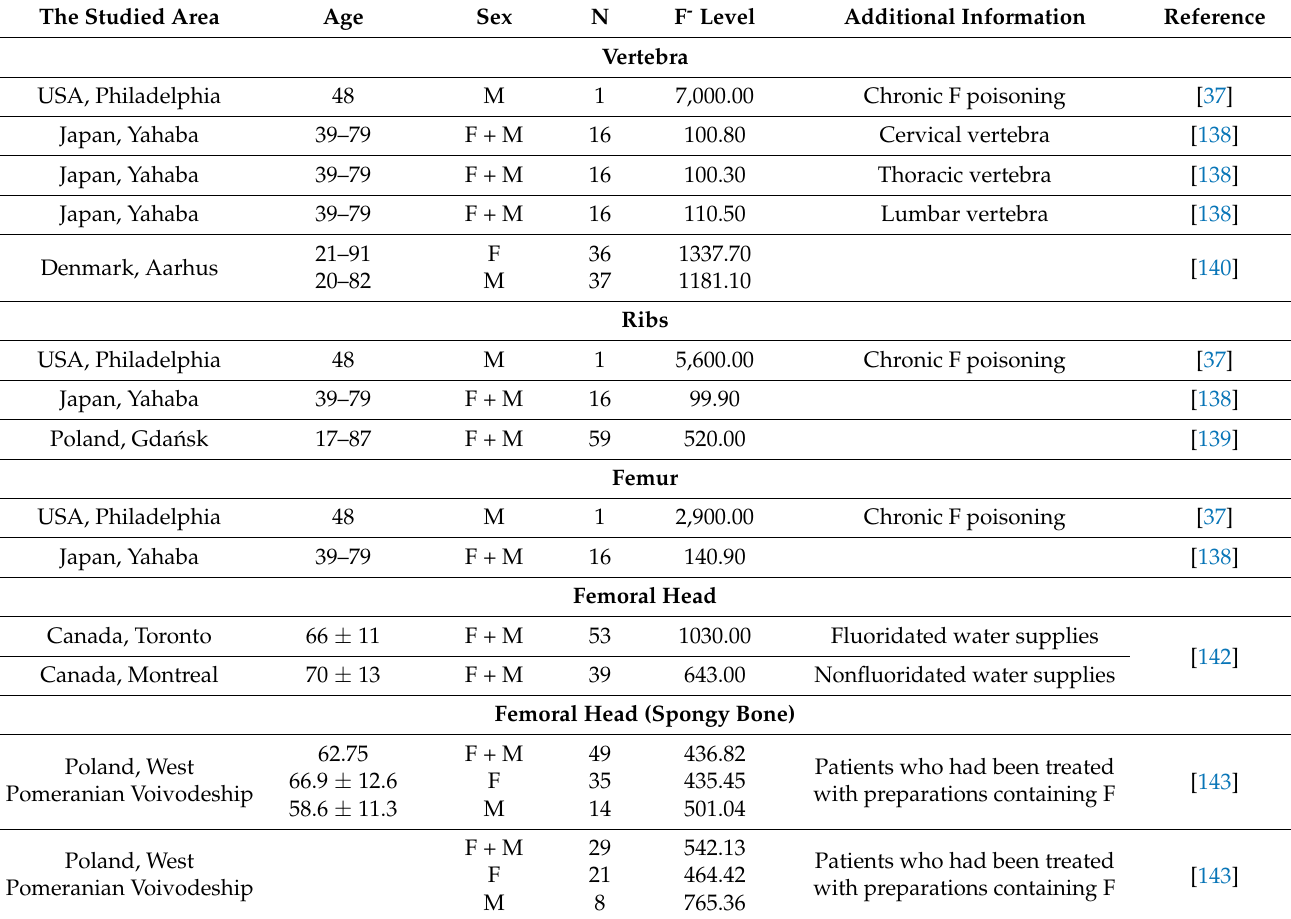
Table 4. The ionic form of fluorine levels in human bones in mg kg − 1 dw. (F, female; M, male; N, number of participants; NS, nonsmoking; S,